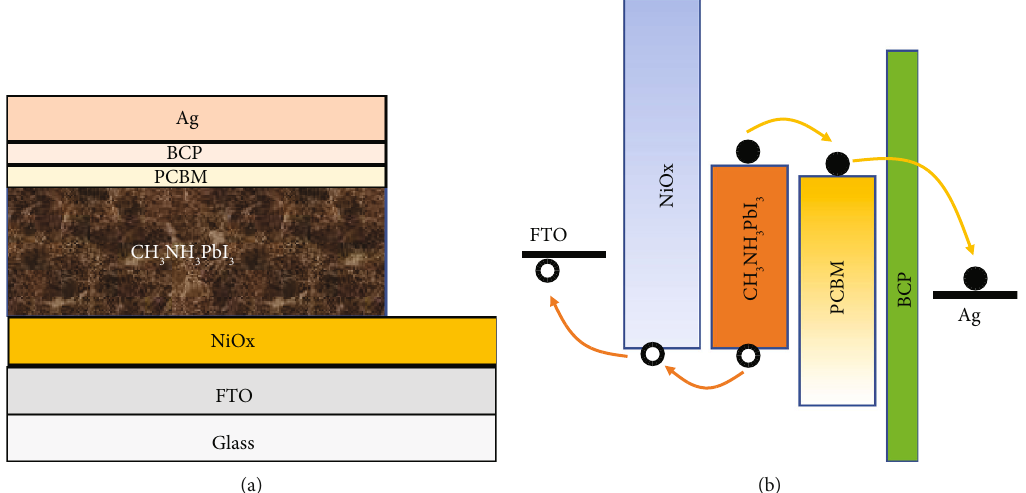
Figure 1: (a) Schematic illustration of the planar PSC architecture; (b) the band alignment and charge carrier transport in the planar PSC.